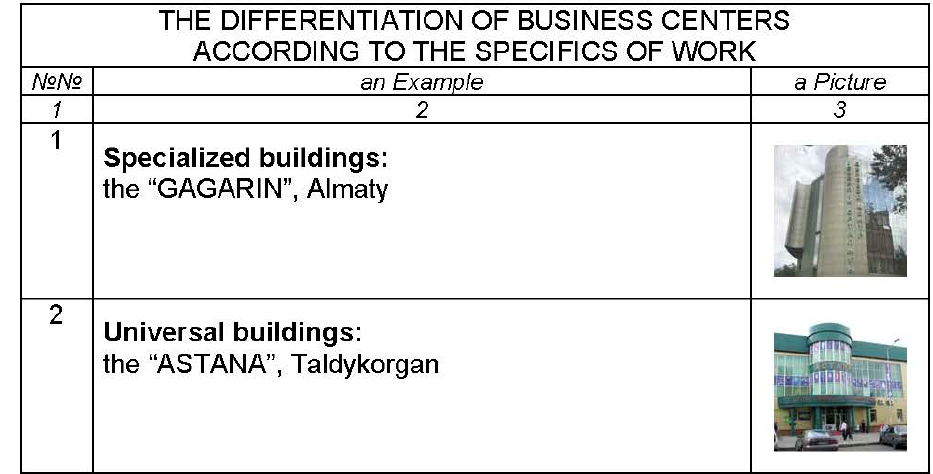
Figure 11. The differentiation of business centers according to the specifics of work: ( 1 ) the GAGARIN, Almaty [116] and ( 2 ) the ASTANA, Taldykorgan [117].